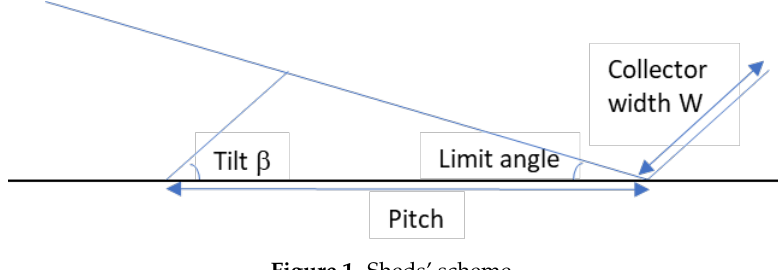
Figure 1. Sheds’ scheme.